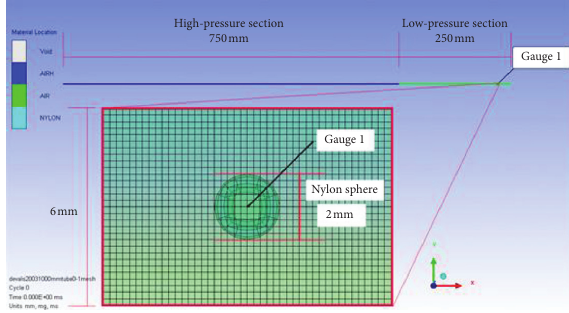
Figure 6: Computing domain and meshing with δ � 0.1 D